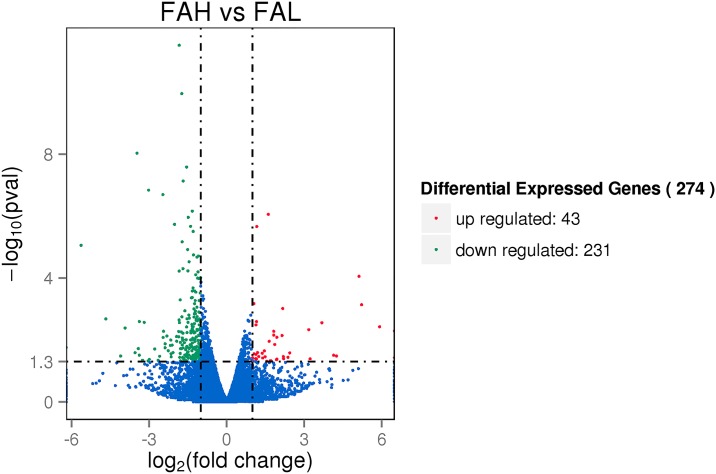
Volcano plot displaying DEGs within two different comparison groups.Note: the y-axis shows the mean expression value of log10(q-value), and the x-axis displays the log2fold change value. The blue dots represent the transcripts did not reach statistical significance (q > 0.05); the red dots represent whose expression levels were significantly different (q < 0.05).